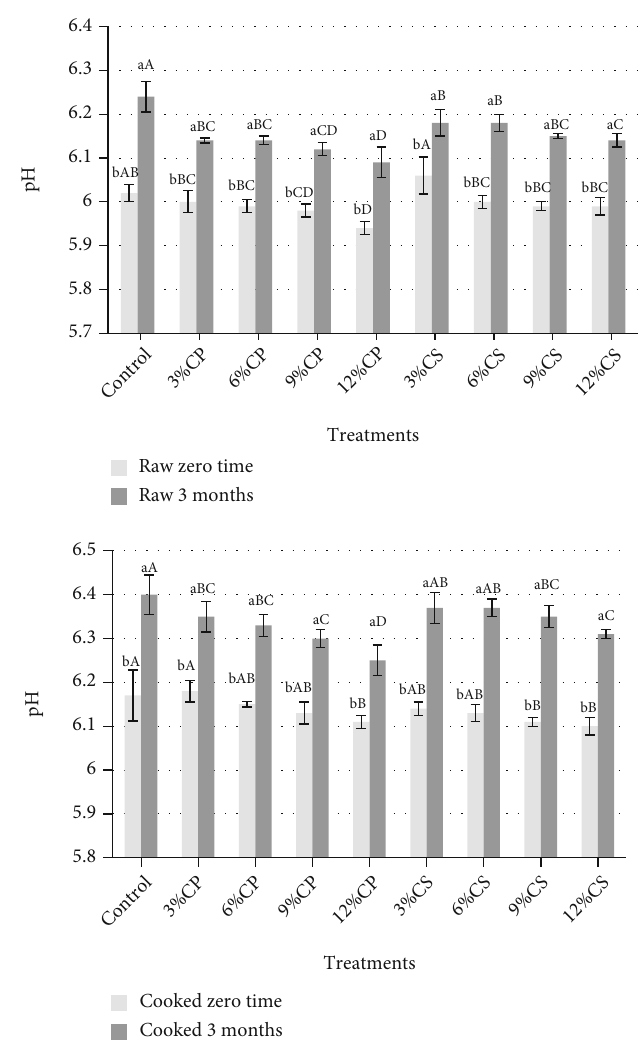
Figure 2: Changes in pH values of raw and cooked chicken patties supplemented with cantaloupe peel (CP) and seeds (CS) powder during storage at -20 for 3